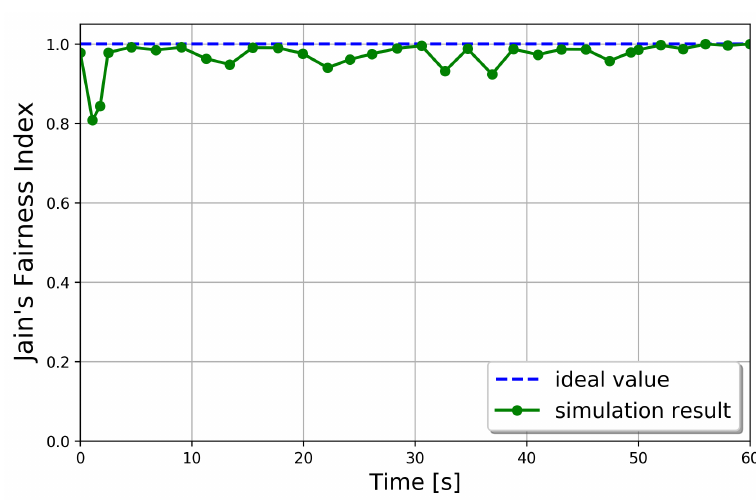
Figure 10. Performance evaluation of the proposed fairness scheme (multipath